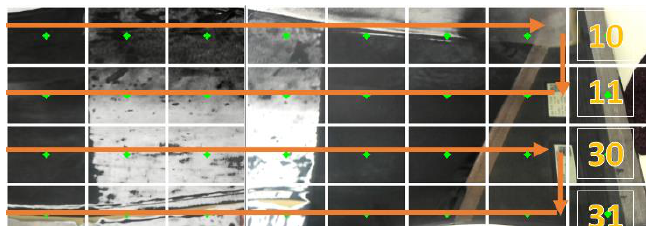
Figure 11. Fan-blade regions of interest for concave side.